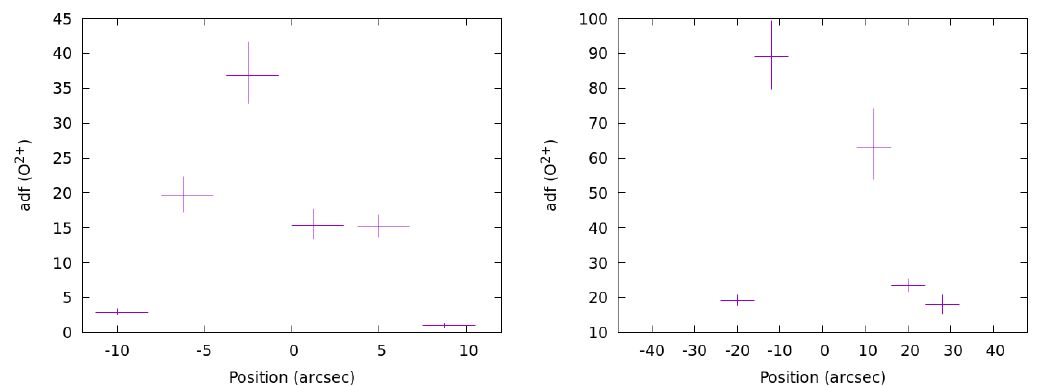
Figure 1. Spatially-resolved analyses of Fg 1 ( top left ), Hf2-2 ( top right ), NGC 6326 ( bottom left ) and NGC 6337 ( bottom right ), showing the variation with slit position of the abundance discrepancy factor ( adf (O 2 + )).